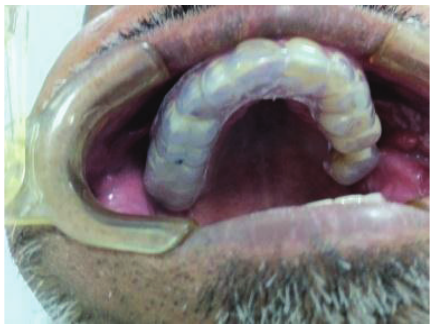
Figure 6: Soft splint on the maxillary teeth.